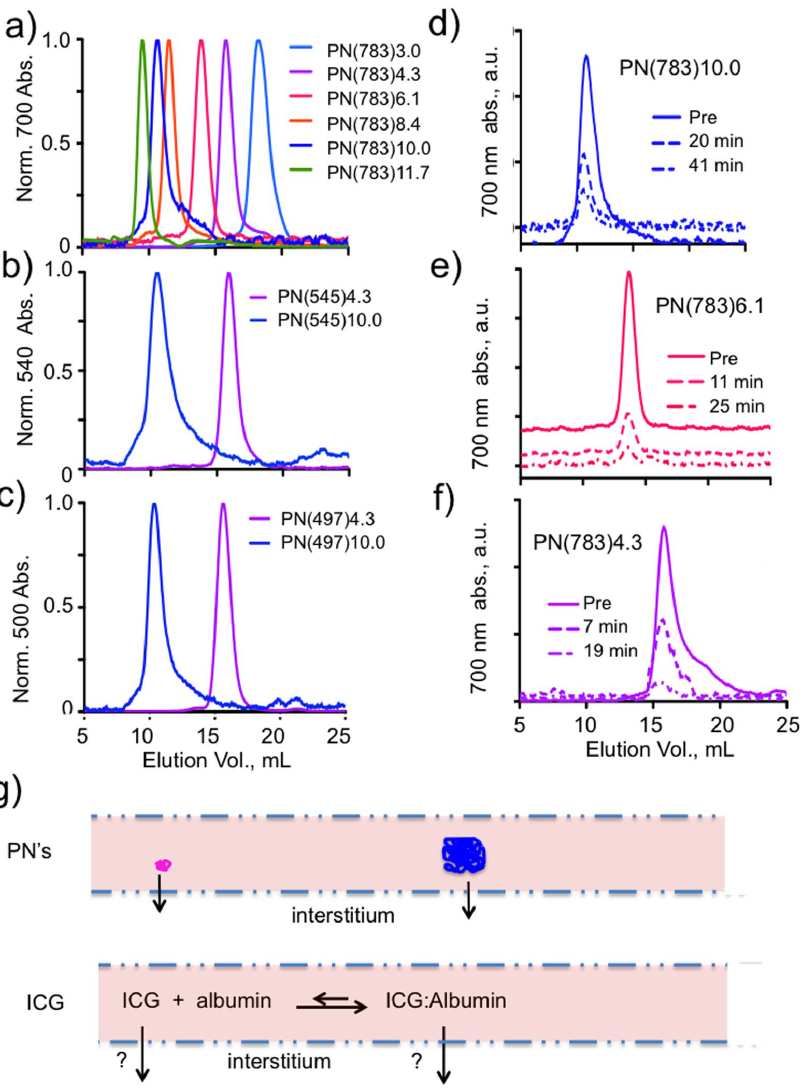
Figure 2. Tuning PN size, optical properties and PN circulating form. A ) FPLC chromatograms of size-variable PN’s (constant IR-783 fluorochrome, variable PEG’s) are shown. Diameters are given in Table 1. B,C ) Tuning PN size with different fluorochromes. The 5 kDa PEG yielded the magenta coded chromatograms with diameters of 4.3 nm regardless of the fluorochrome used. They are PN(783)4.3 ( 2A ), PN(545)4.3 ( 2B ), and PN(497)4.3 ( 2C ). The 30 kDa PEG yielded the blue coded PN’s of 10 nm. Therefore PN dimensions are determined by PEG and independent of the fluorochrome selected. ( D,E,F ) FPLC chromatograms of PN’s are shown before (pre) and from the sera of injected mice. PN’s were PN(783)10.0 ( 2D ), PN(783) 6.1 ( 2E ), and PN(783)4.3 ( 2F ). After injection, PN’s circulate at their PEG-determined and variable pre-injection sizes. ( G ) Since PN’s circulate at PEG-determined, pre-injection sizes, they cross capillaries at those sizes. ICG binds albumin and can cross capillaries in two forms . " FL " is